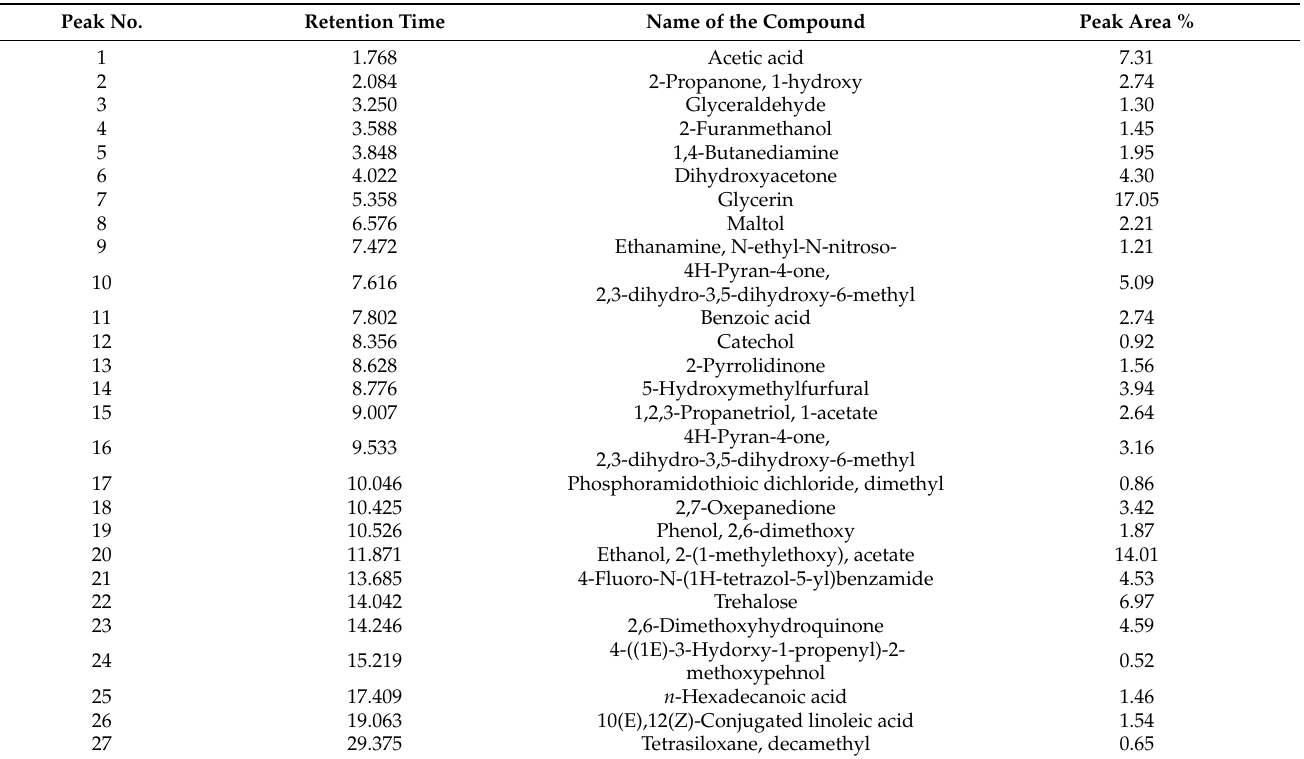
Table 1. Phytochemical analysis of C. semidecandrus Jack ethanol extract by GC-MS. Peak